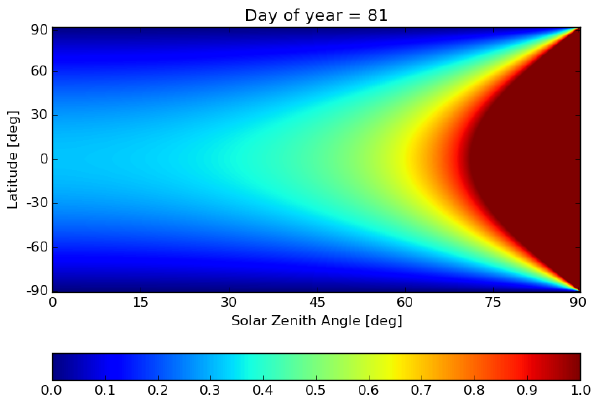
Figure 1. An example of normalization factor for day 81 of a year as a function of latitude and solar zenith